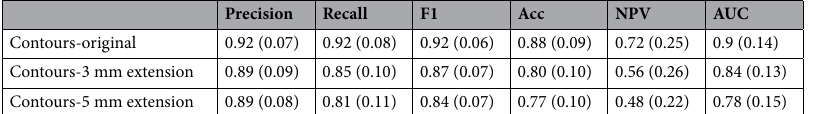
Precision Recall F1 Acc NPV AUC Contours-original